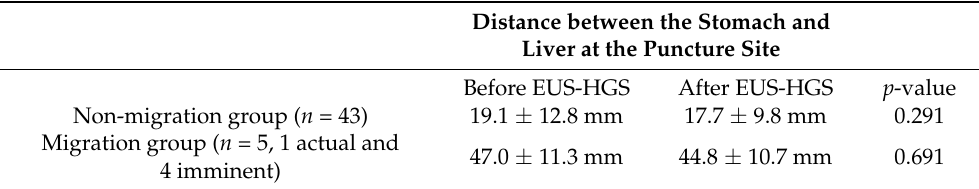
Table 5. Distance between the stomach and liver at the puncture site before and after EUS-HGS in the migration and non-migration